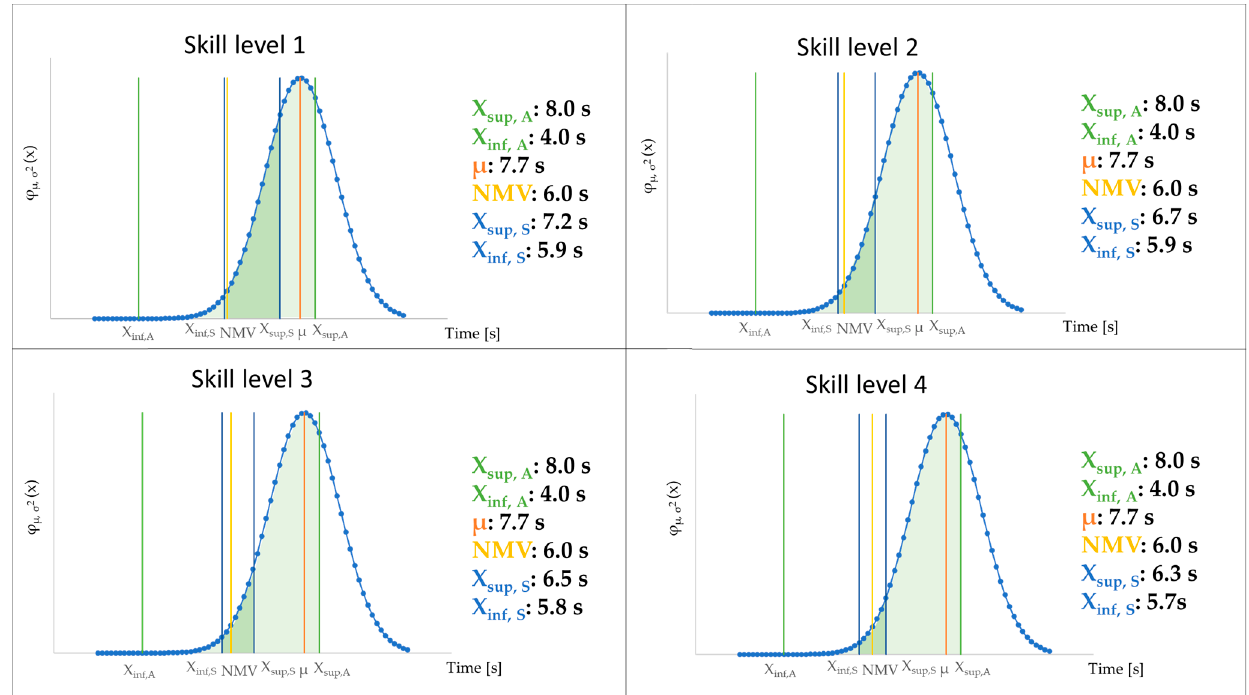
Figure 18. Gaussian distribution of the grasping in workstation C.